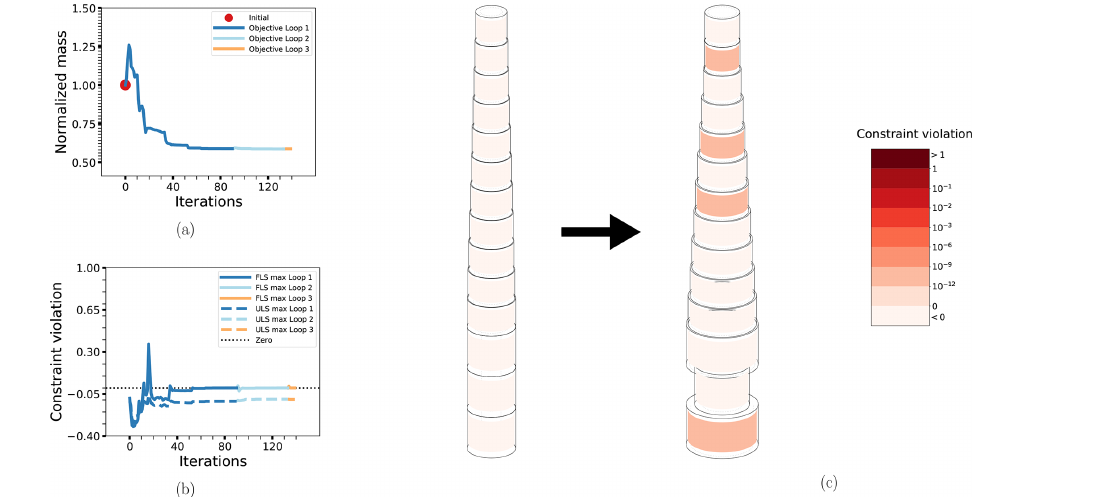
Figure 10. The optimization process for case OC3-PA: the objective function (a) , maximum non-linear constraint violations (b) and the change in the design from initial to final configuration (c) . Details as in previous figures.